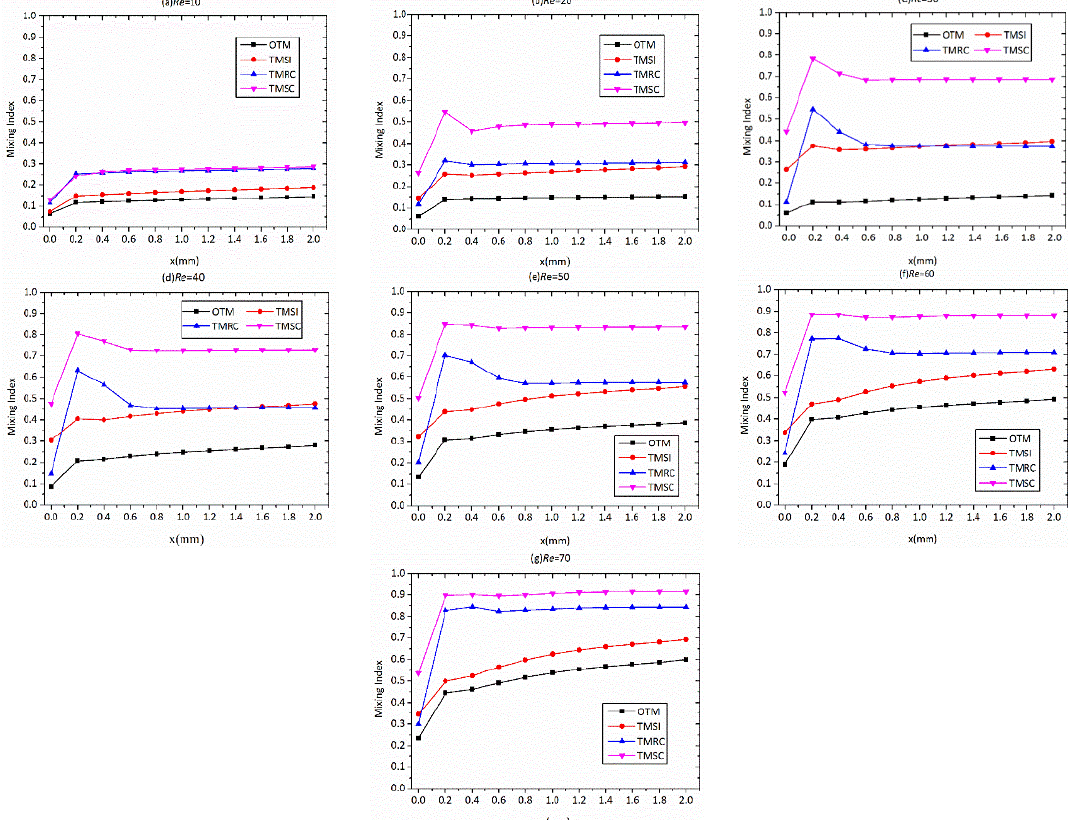
Figure 7. The comparison of the mixing index along the mixing channel for different micromixers at different Reynolds numbers: ( a ) Re = 10, ( b ) Re = 20, ( c ) Re = 30, ( d ), Re = 40, ( e ) Re = 50, ( f ) Re = 60, ( g ) Re = 70.